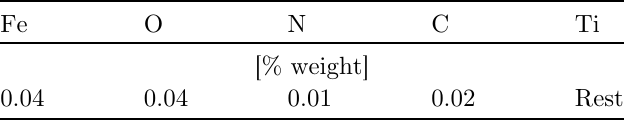
Table 1. Chemical composition of titanium.